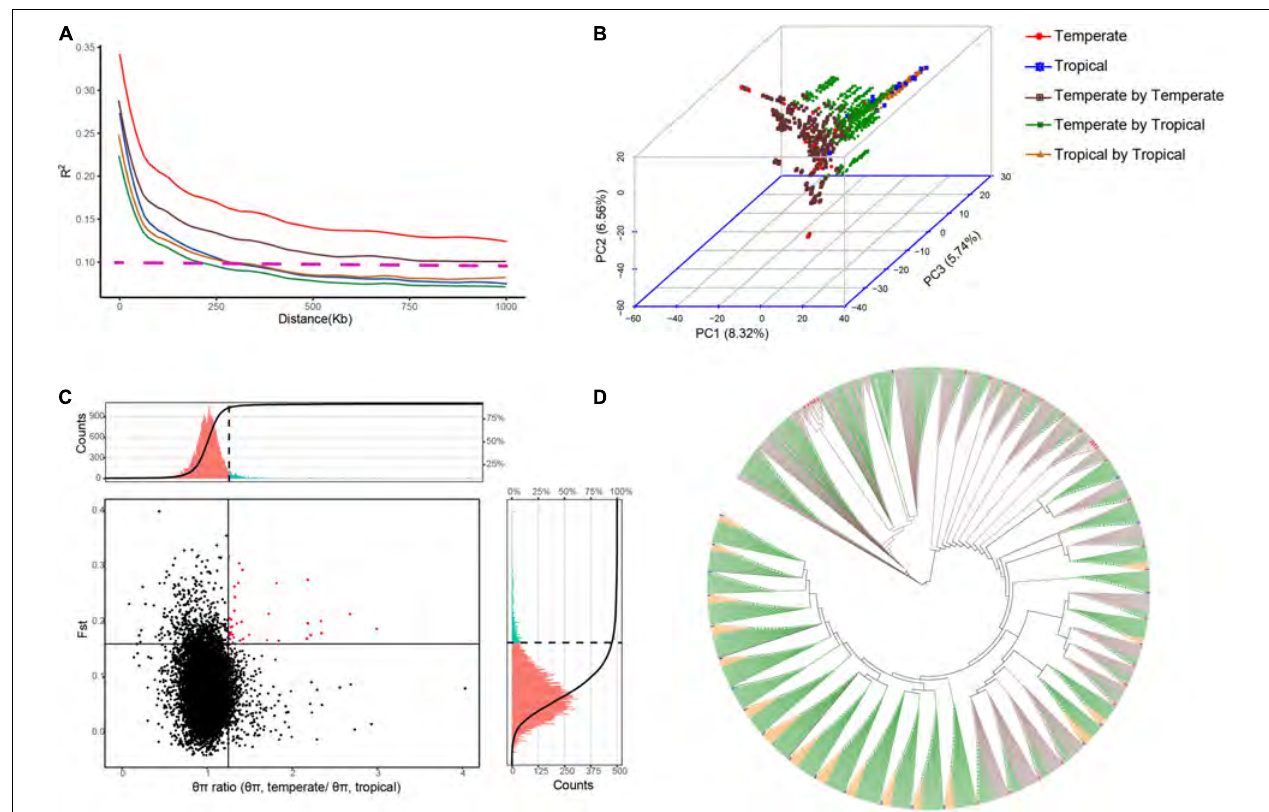
FIGURE 1 | Genetic diversity identified among the hybrids in multiple hybrid populations. Population structure and LD were analyzed for 28 temperate parents, 23 tropical parents, and 1,154 hybrids from the multiple hybrid populations. (A) LD decay ( R 2 ) is plotted as a function of the genetic map distance based on pairwise correlations of the LD phase. Horizontal dotted lines represent LD decay lower than 0.1. (B) Principal component analysis (PCA) based on the maximum likelihood method. The numbers in the parentheses are genotypic variance proportions explained with the PC1, PC2, and PC3. (C) Genome-wide selective sweep analysis on tropical and temperate maize groups. Vertical and horizontal solid lines represent threshold lines for the top 5% of θπ ratios and F ST values, respectively. Red dots in the right upper sector indicate selective signatures for temperate maize lines. The portions of histograms in red and blue colors indicate the θπ ratio (upper) and the F ST (right) values above the thresholds. (D) Neighbor-joining tree based on genetic